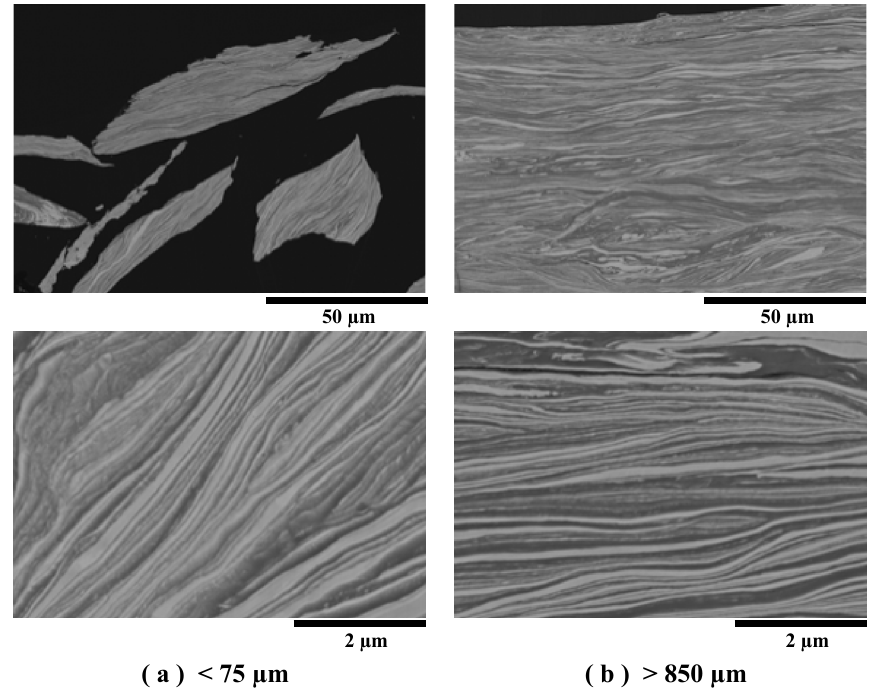
Figure 6. COMPO images of the ( a ) under 75 and ( b ) over 850 µ m classified Al / Ni multilayer powders.